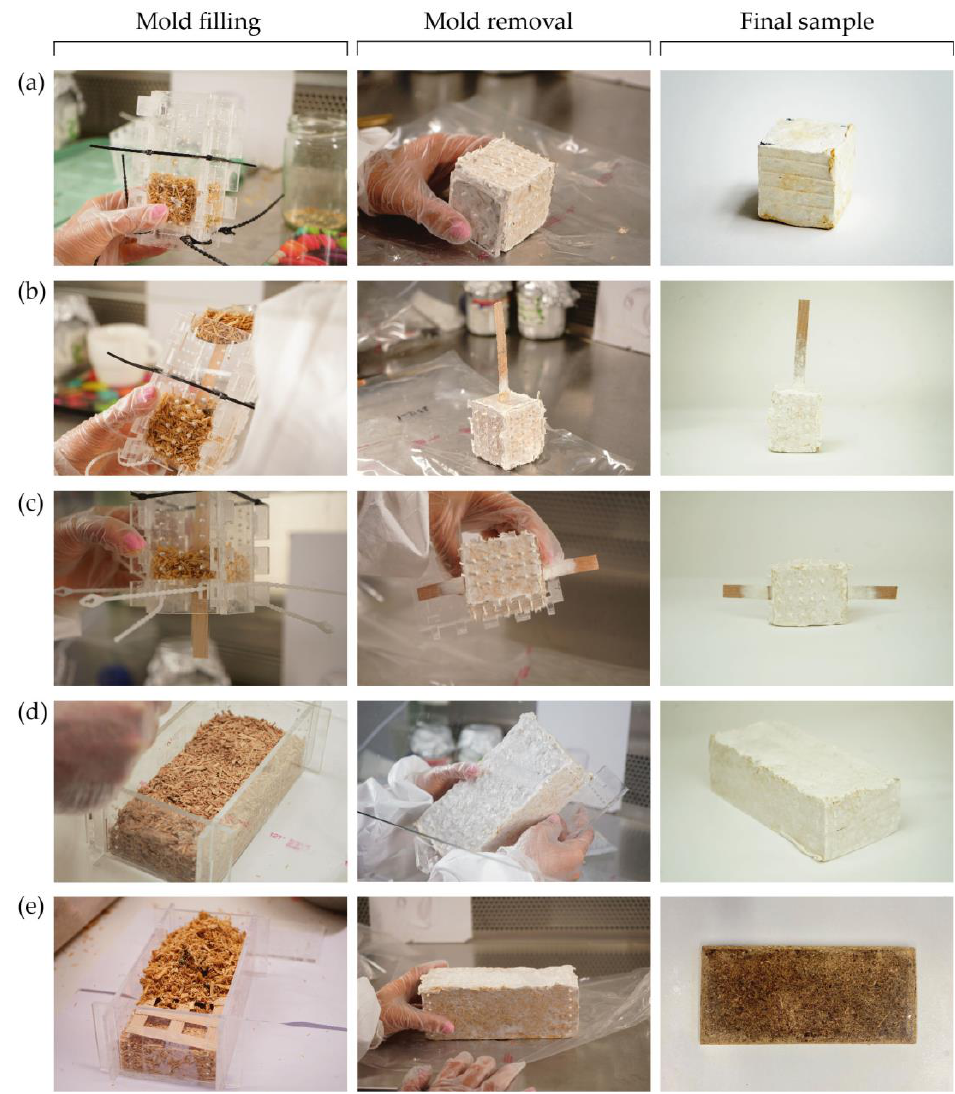
Figure 5. Mycelium compos ite samples’ production process: ( a ) Compressive strength test cube; ( b ) One-side single veneer pull-out test cube; ( c ) Two-side, middle overlapped veneer with and without welding reinforced cube; ( d ) Lightweight block with and without low- and high-density lattices; ( e ) Pressed board with and without low- and high-density lattices.